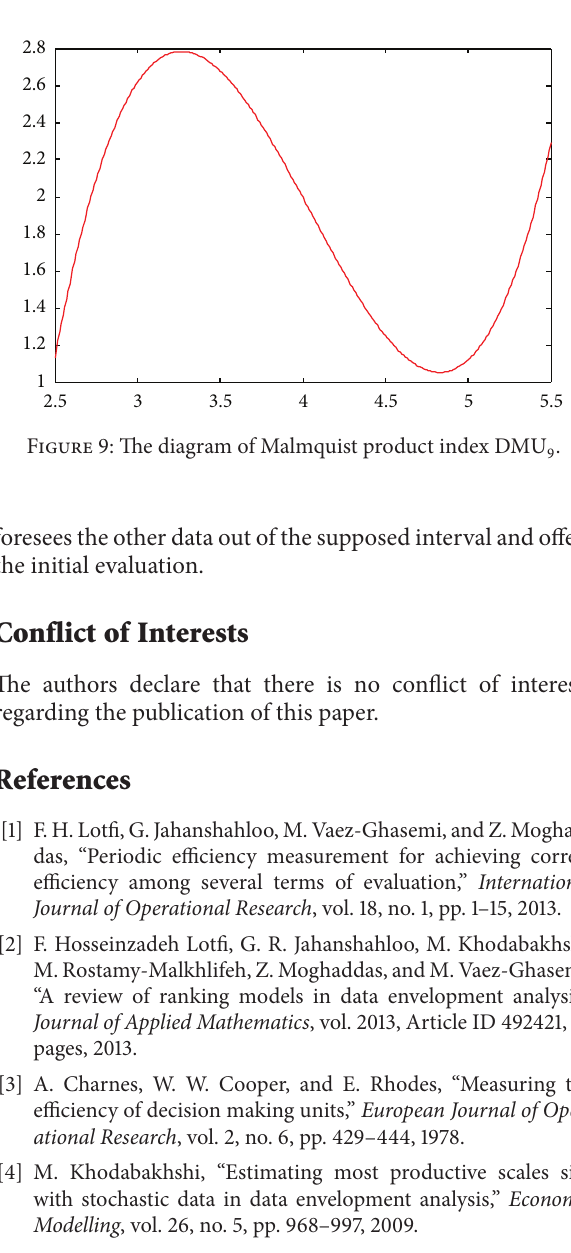
Figure 8: The diagram of Malmquist product index DMU 8 .